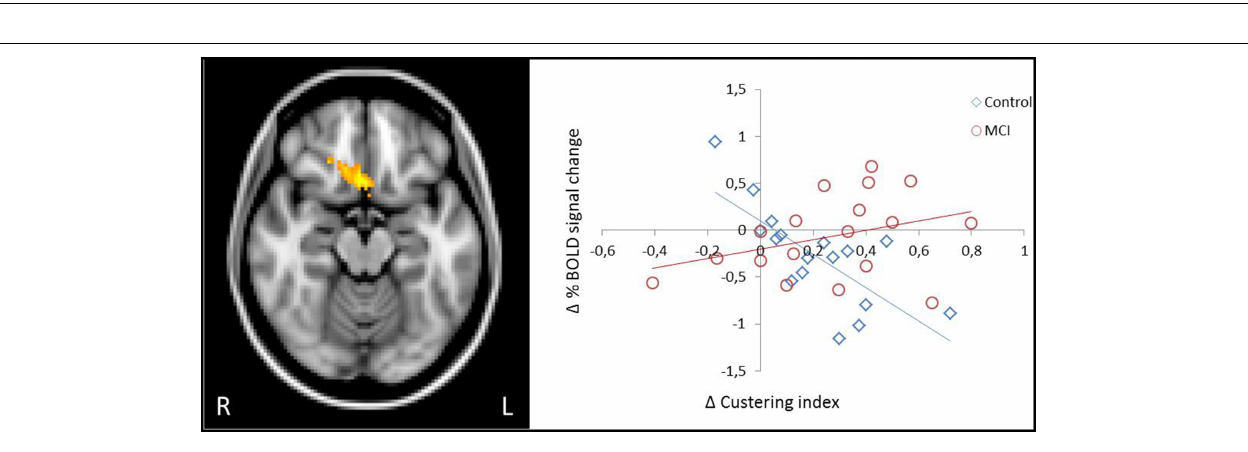
FIGURE 3 | Different patterns of association between change in semantic clustering and change in activation due to the explicit application of the encoding strategy in the OFC. In controls, greater